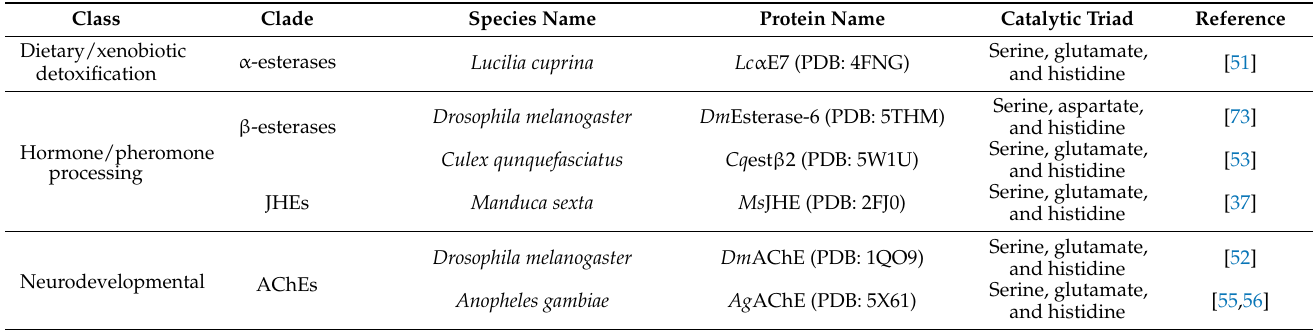
Table 2. The information of CCE genes in insect species that have 3D structures